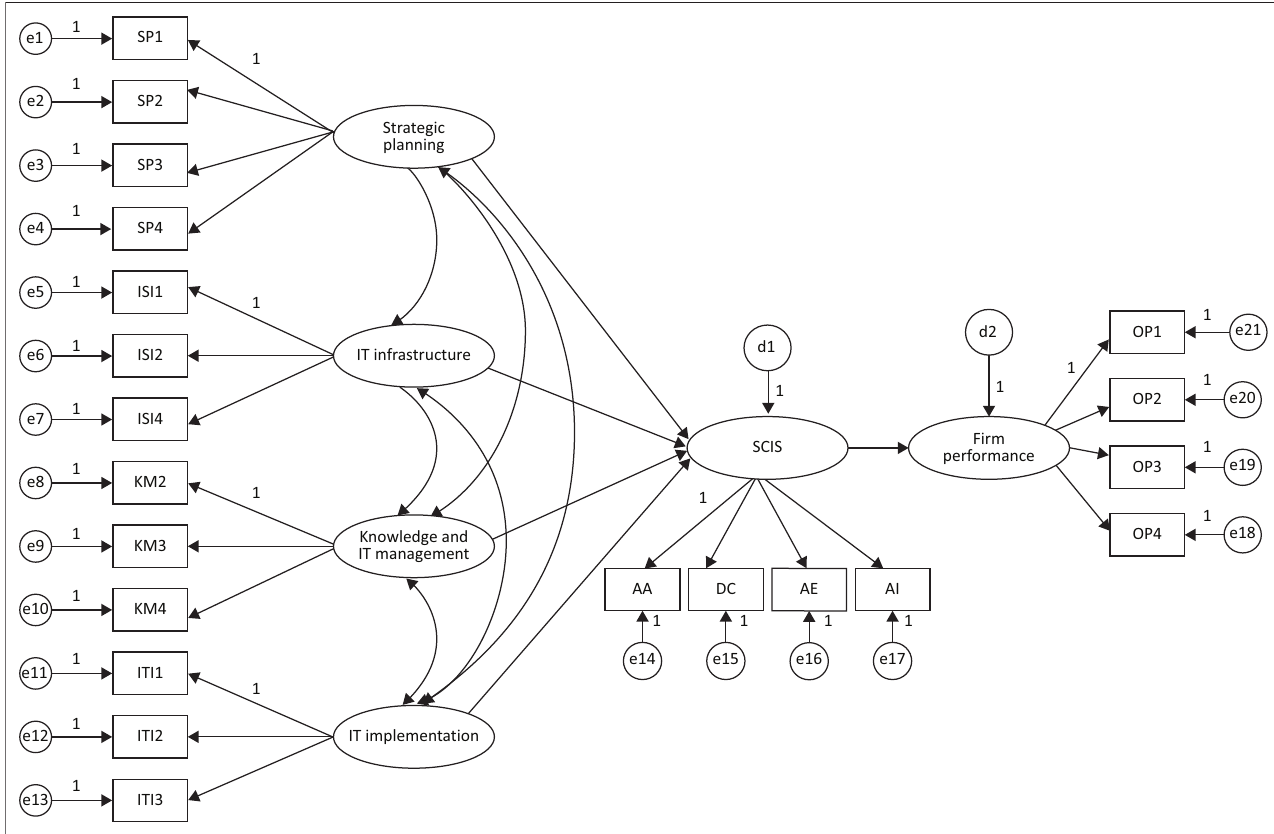
FIGURE 1 : Proposed structural